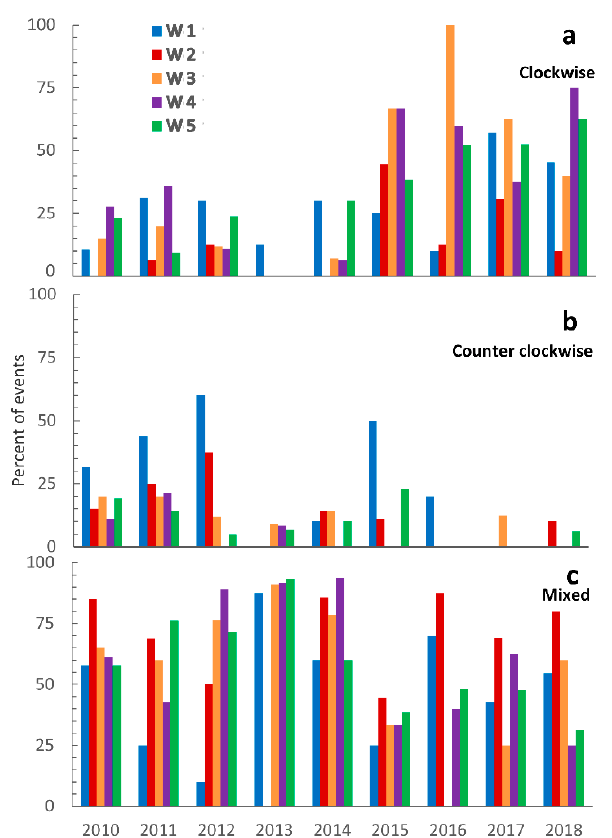
Figure 10. Hysteresis in the sediment concentration and discharge at the outlet of the four nested watersheds W1–W4) and the main watershed W5 of Debre Mawi watershed. ( a ) Clockwise loops; ( b ) Counter-clockwise loops, and ( c ) Mixed loops. The location of the watersheds is given in Figure 1.